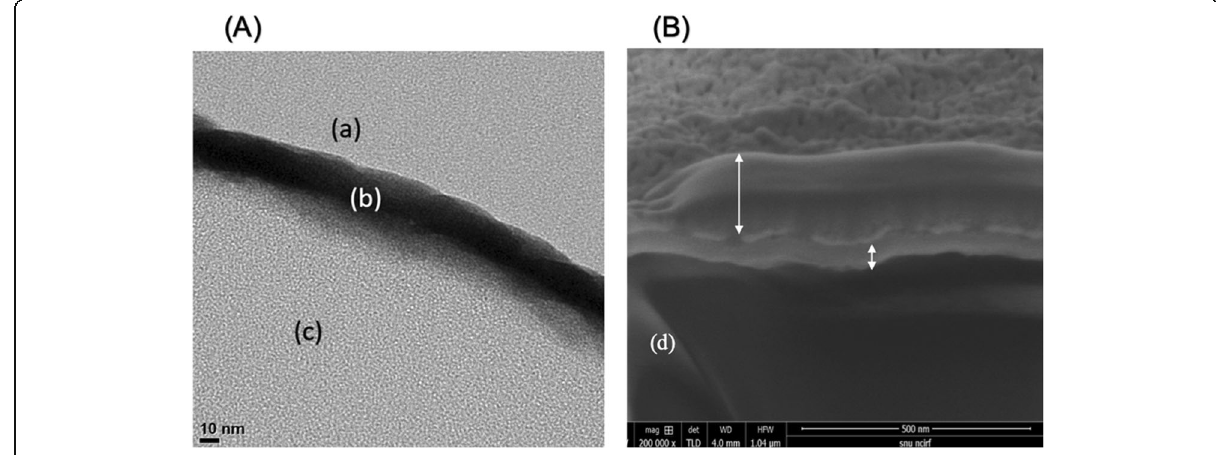
Fig. 2 Transmission and scanning electron microscopy images of a tantalum implanted ePTFE implant material. A Transmission electron microscopy images: (a) A protective carbonic layer was formed on the implant material surface after treatment with Ta. (b) Ta layer after implantation. (c) ePTFE implant material. B Scanning electron microscope images: long two-headed arrows, protective carbonic layer. Short two- headed arrow, Ta layer after ion implantation. (d) ePTFE implant